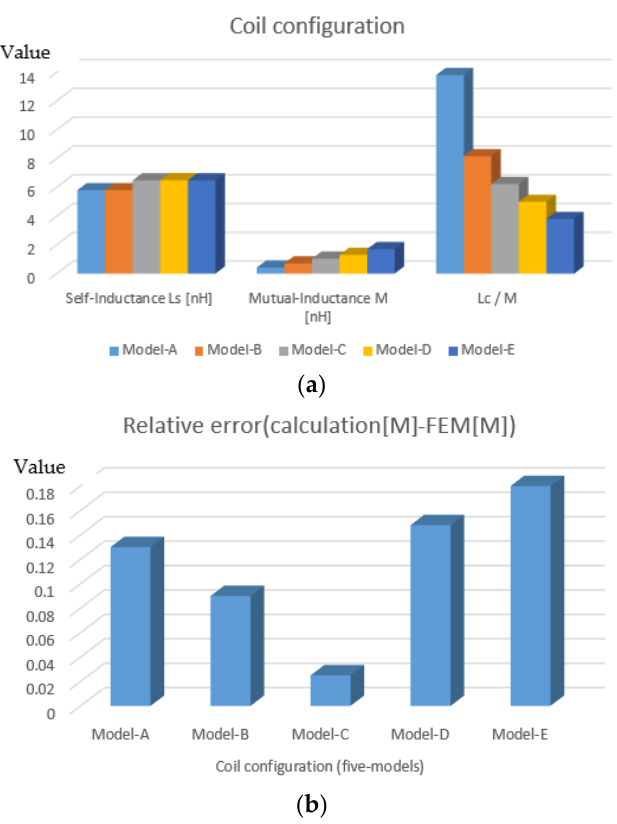
Figure 5. Comparison for the five models. ( a ) FEM results under different coil configurations and ( b ) error value of M between calculation results and FEA results.